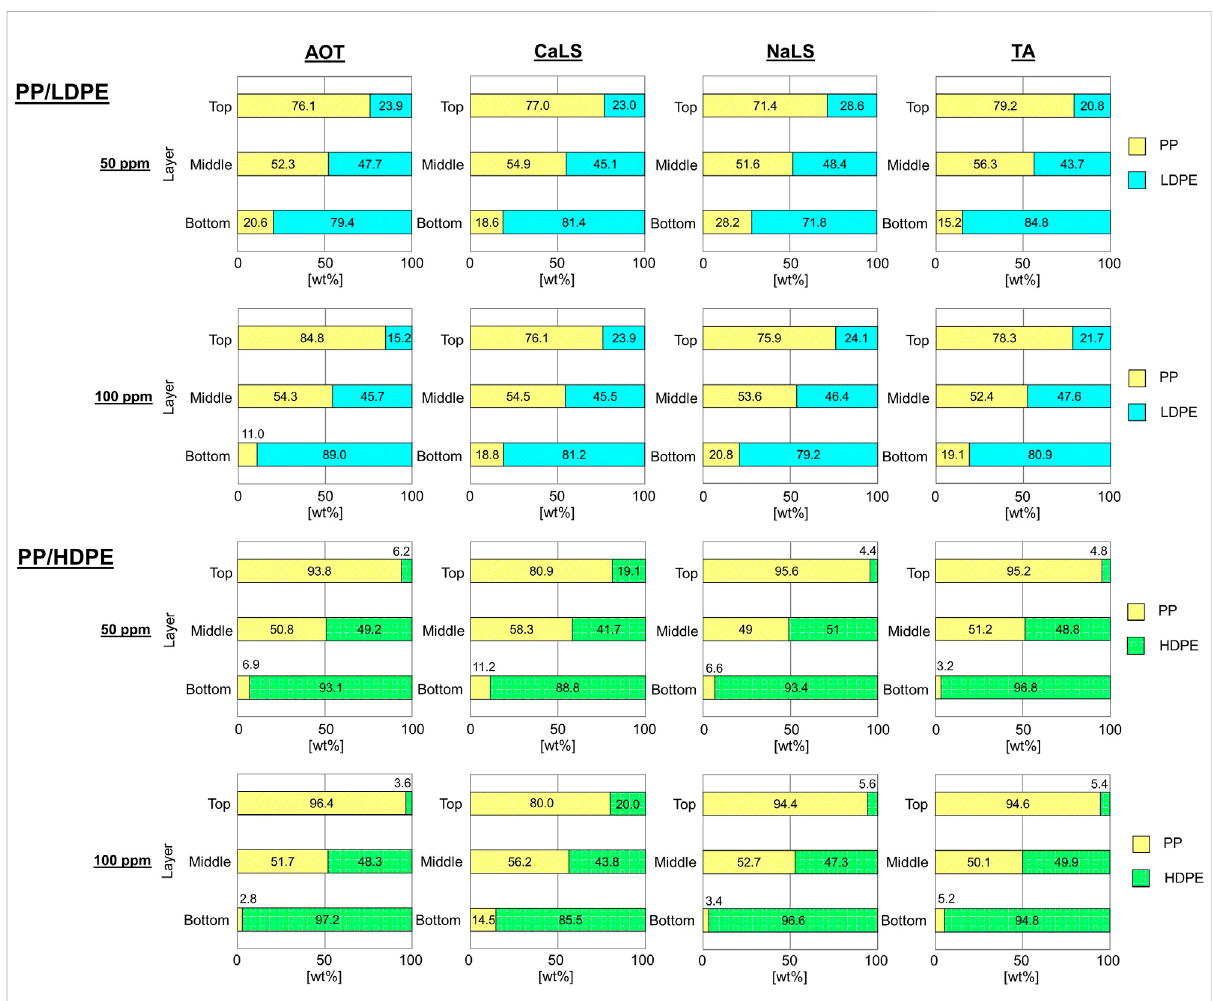
FIGURE 8 Theproportion ofplastics ineachlayerafterreverse hybridjigseparationofPP/LDPE andPP/HDPEwithoutbubble generationduringpulsation at air fl ow rate of 1.0 L/min with AOT, CaLS, NaLS, and TA at concentrations of 50 and 100